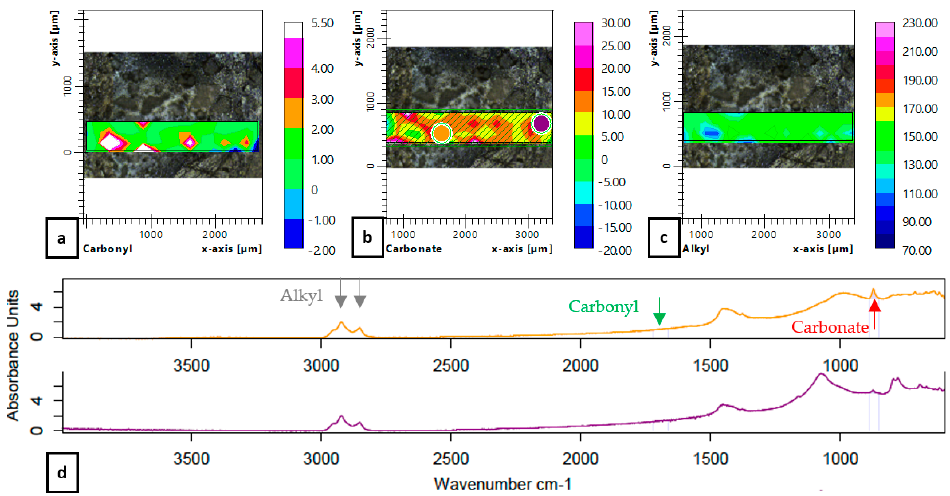
Figure 10. Chemical imaging of the GRAB sample (Area 3): carbonyl group ( a ); carbonate group ( b ); alkyl group ( c ); spectral visualization of the selected points marked by colored dots in Figure 10b ( d ).